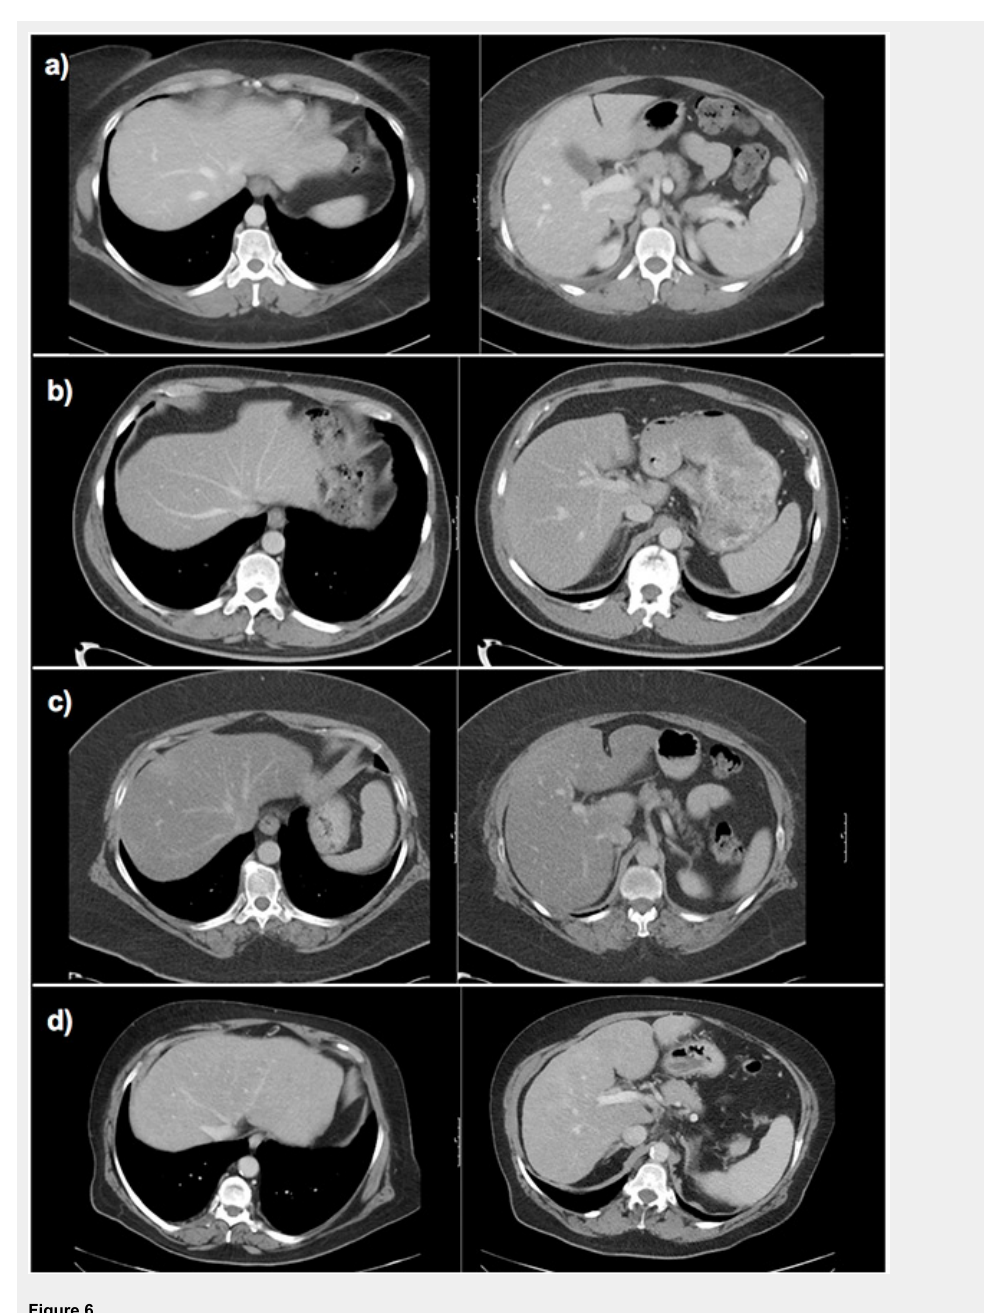
Figure 6 Fibrosis assessment with the ld/crl ratio in different patients. a) Normal liver: wide hepatic veins, caudate lobe smaller than right liver lobe on visual impression. Calculation of the ld/crl-r not mandatory (ld: 2.5 cm, crl-r: 0.75, ld/crl-r: 33.2). b) Hepatitis C fibrosis grade 1: small hepatic veins, caudate lobe width similar to right hepatic lobe width on visual impression, calculation of the ld/crl-r recommended (ld: 1.5 cm, crl-r: 0.78, ld/crl-r: 19.2). c) Nonalcoholic steatohepatitis fibrosis grade 1: small hepatic veins, caudate lobe width similar to right hepatic lobe width on visual impression, calculation of the ld/crl-r recommended (ld: 1.6 cm, crl-r: 0.79, ld/crl-r: 20.2). d) Alcoholic steatohepatitis cirrhosis: very small hepatic veins, caudate lobe width similar to right hepatic lobe width on visual impression, calculation of the ld/crl-r recommended (ld: 1.4 cm, crl-r: 1.1, ld/crl-r: 12.7). crl-r = caudate-right lobe ratio; ld score = sum of liver vein diameters; ld/crl-r = ld score divided by